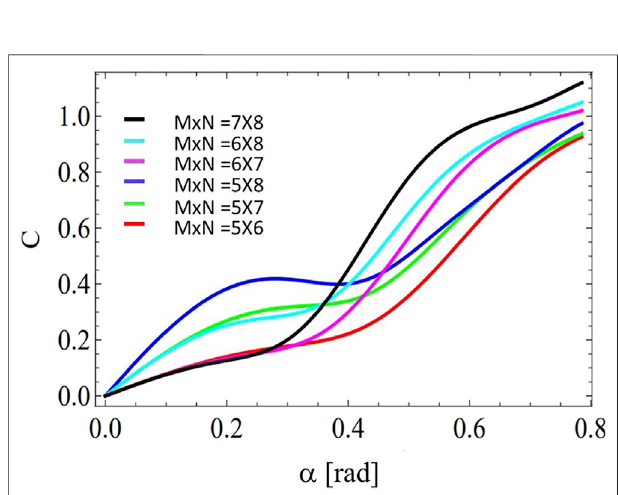
FIGURE 5 | Concurrence vs. angular aperture size for different path dimensions( M × N ) and aperture sizesinthe range [0, 2 π / N max ] with N max = 8. Details are in the